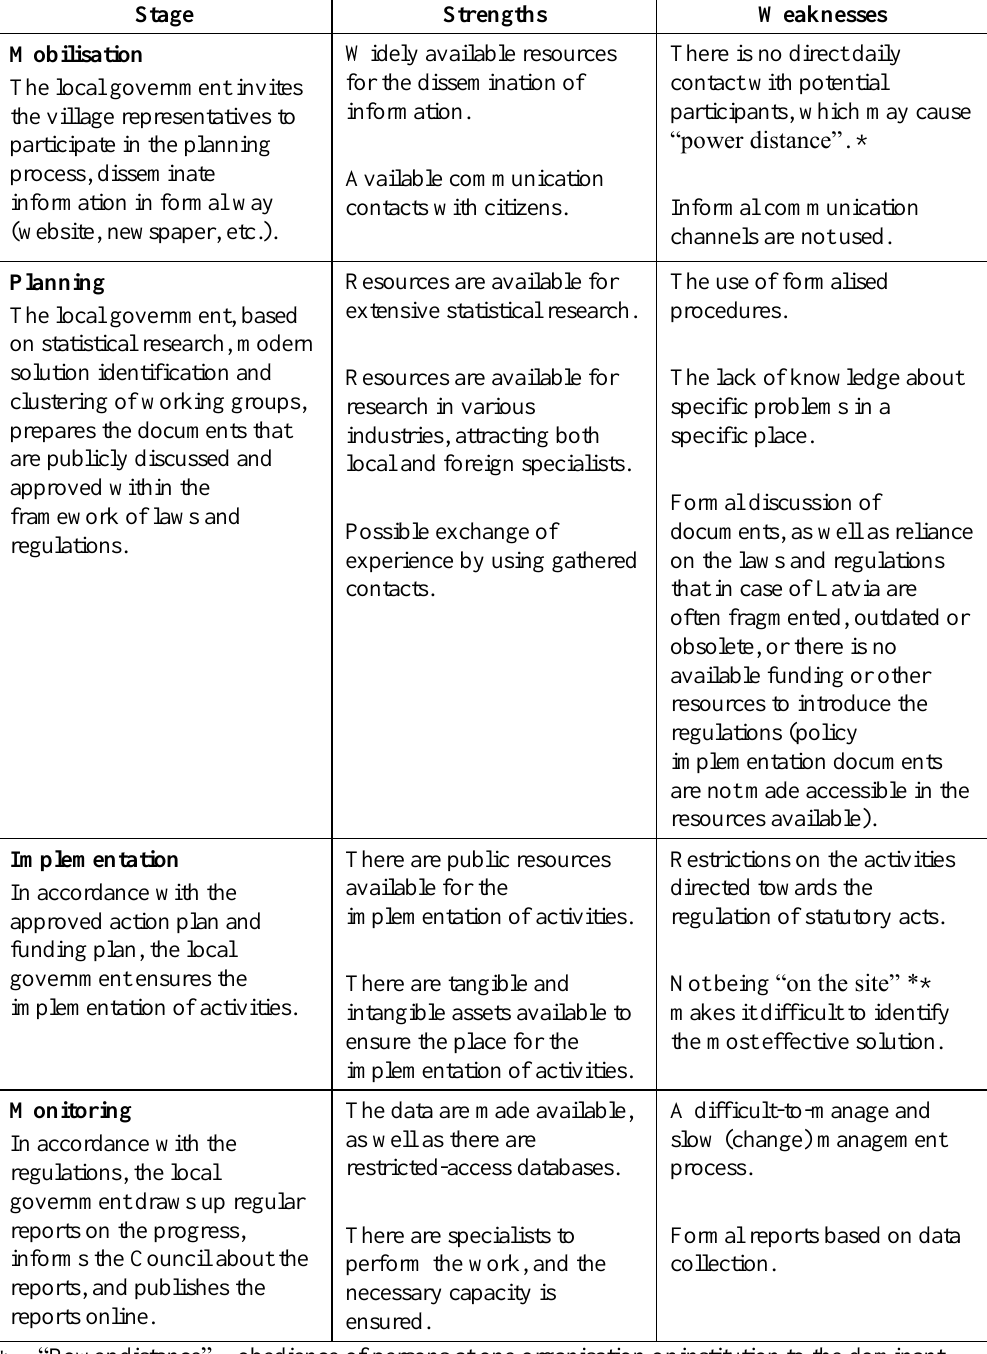
Table 1. Formal Planning Model (developed by the authors) Stage